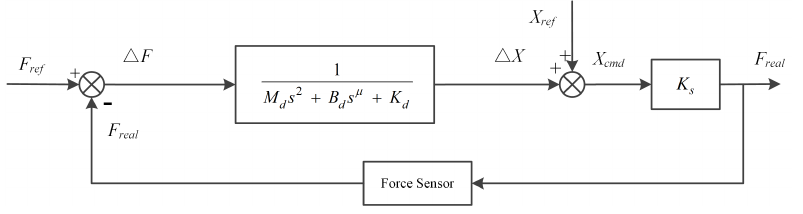
Figure 4. FO-impedance